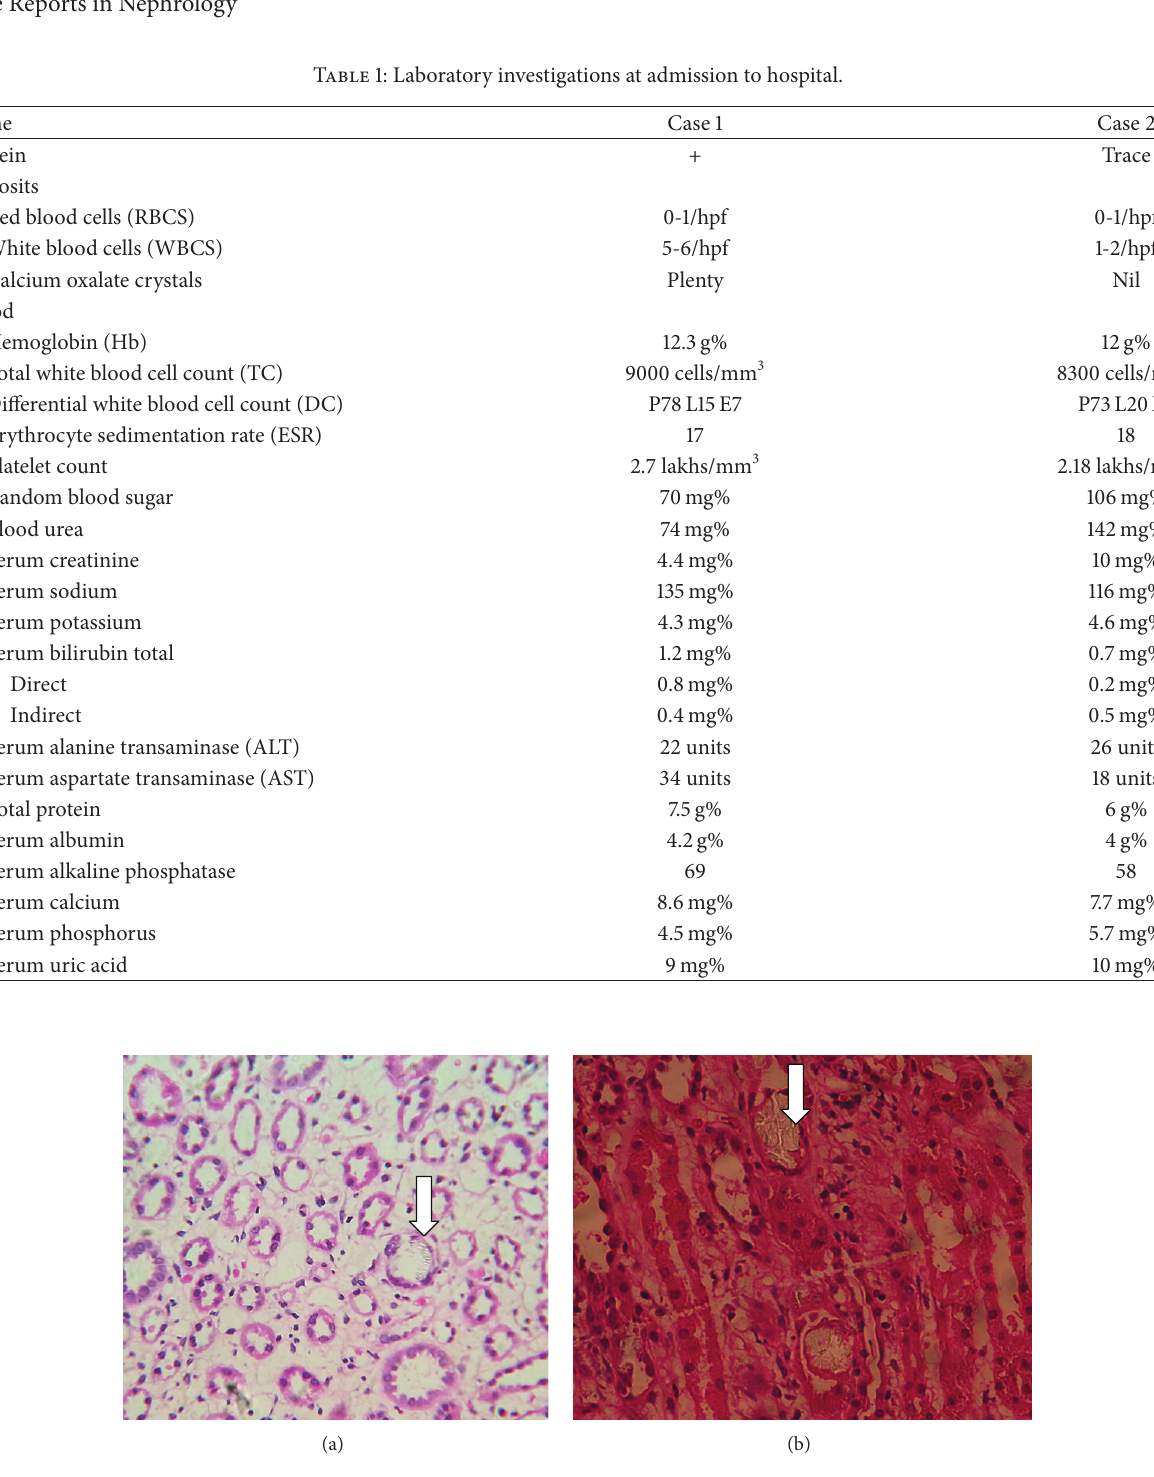
Figure 3: Renal biopsy specimen ( 40 X) with arrow showing calcium oxalate